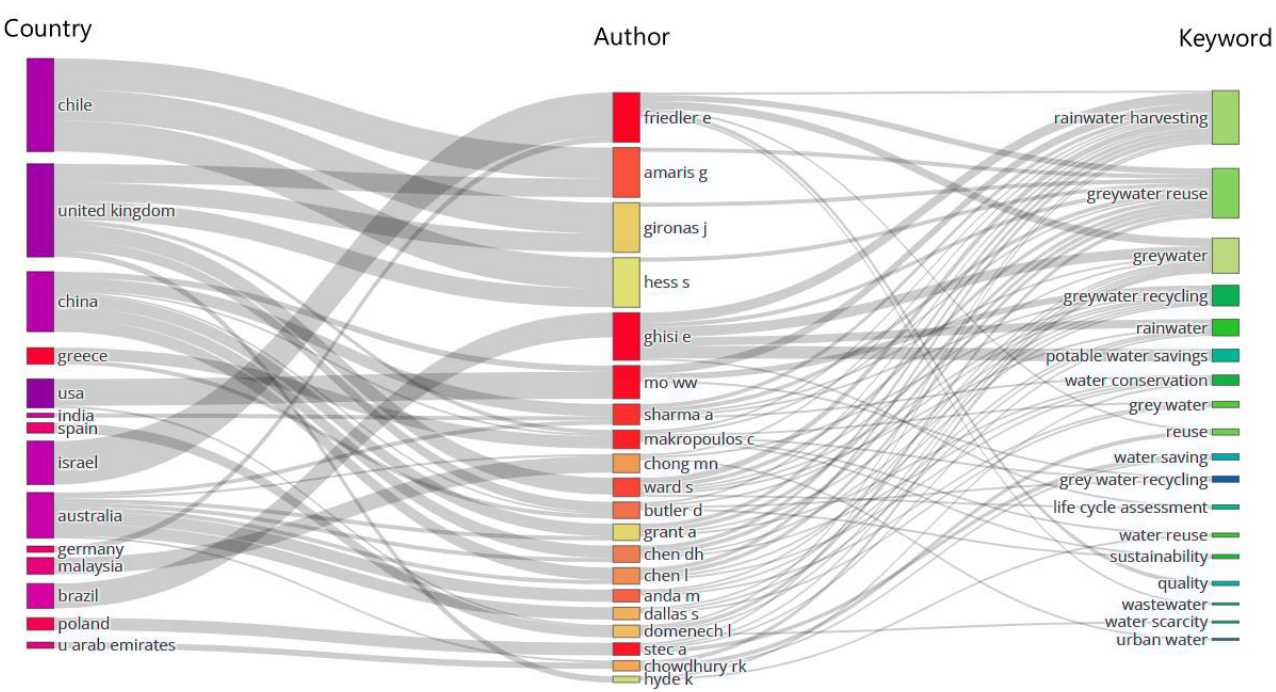
Figure 13. Sankey diagram for greywater recycling research.